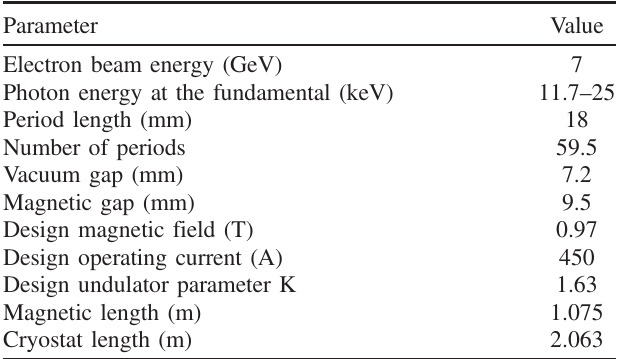
TABLE I. Design parameters of SCU1.